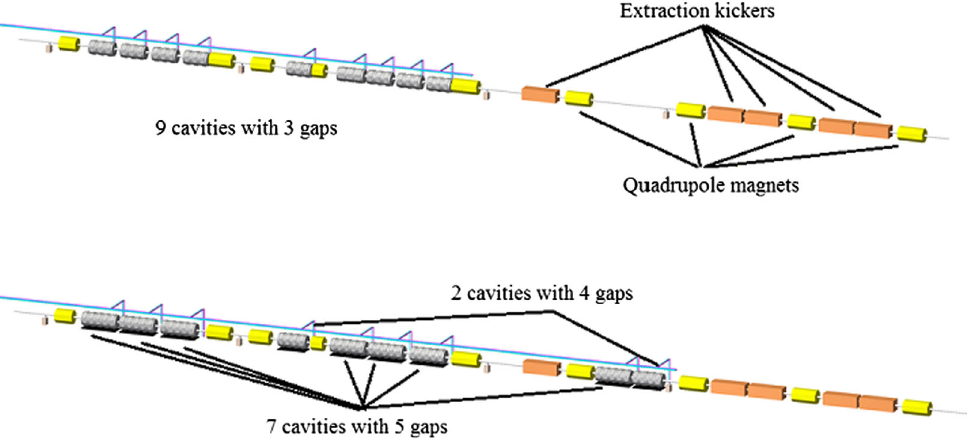
FIG. 13. Upgrade scenario of the J-PARC MR cavities. The present cavities (upper) will be replaced by the FT3L cavities (lower) in 2014–2016. The total rf voltage will become 560 kV providing enough margin as the required rf voltage for 1 Hz operation is 440 kV according to a